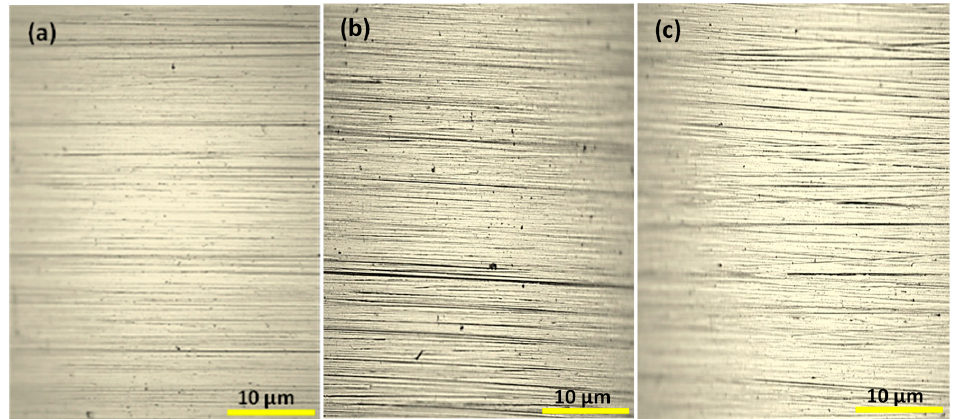
Figure 10. Optical micrographs of AISI 304L stainless steel. Initial condition ( a ), after test of erosion– corrosion ( b ), and after test for pure erosion ( c ), in tailings slurries at 6000 rpm.